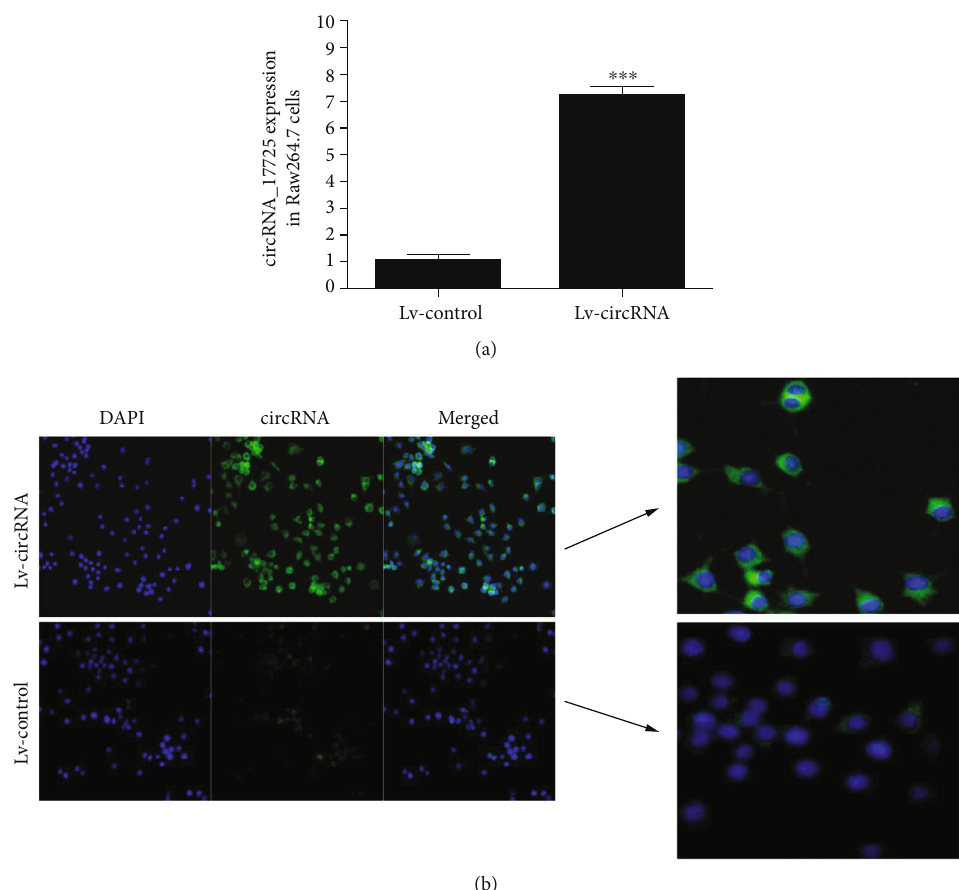
Figure 4: Location of circRNA_17725 in macrophages. (a) Real-time PCR: circRNA_17725 expression in Raw264.7 macrophages ( ∗∗∗ P < 0 : 001 ; n = 3 ). (b) FISH: location of circRNA_17725 in Raw264.7 macrophages (representative pictures;